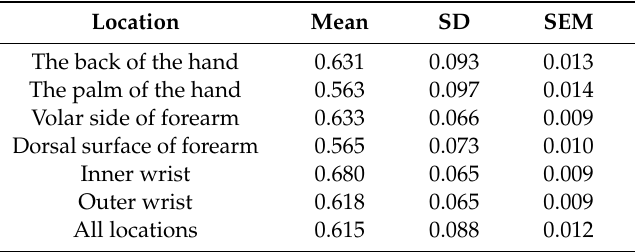
Table 1. An overview of the descriptive stats of the human skin reflectance over a sample of 50 healthy participants at a center frequency of 90 GHz.